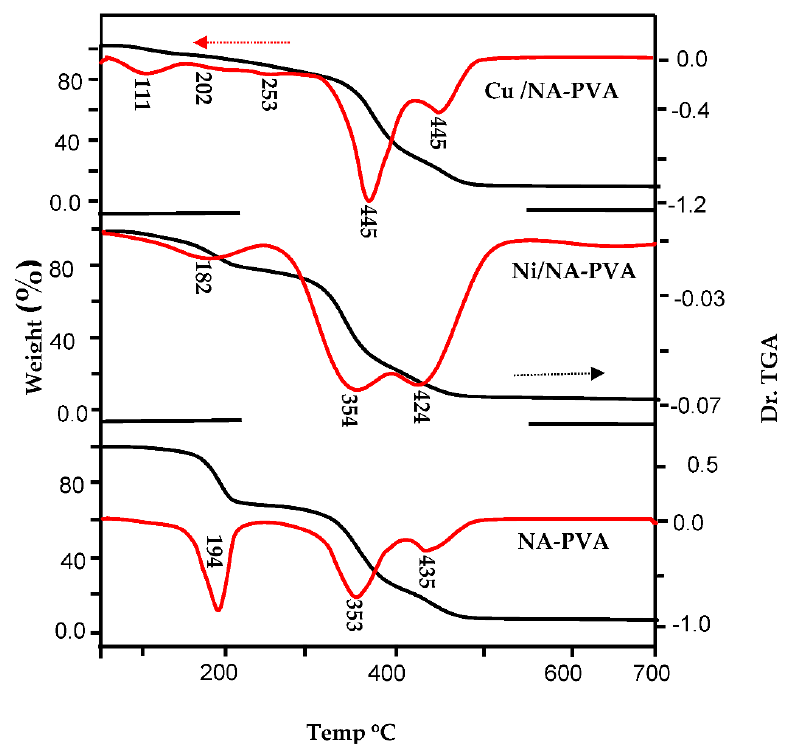
thermal stability in copolymers with PVA higher than parent PVA.